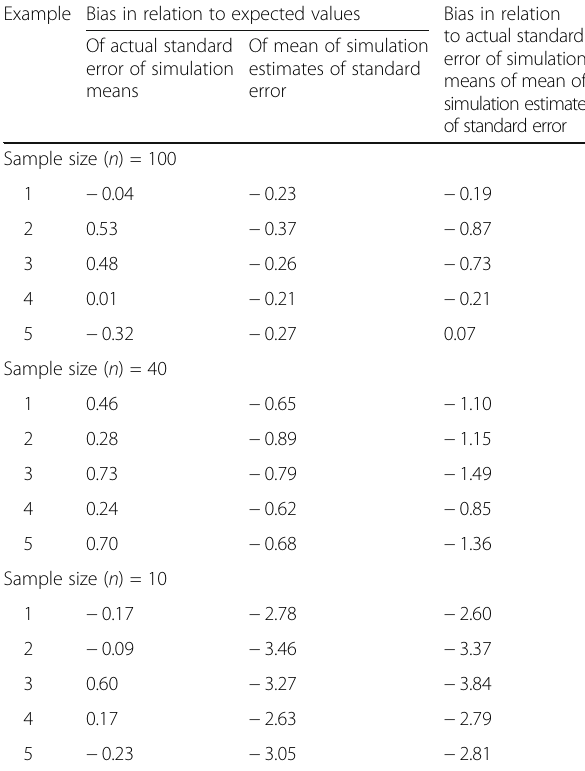
Table 3 Bias (%) in estimates of standard errors of estimates of the population mean in inventory using simple random sampling Example Bias in relation to expected